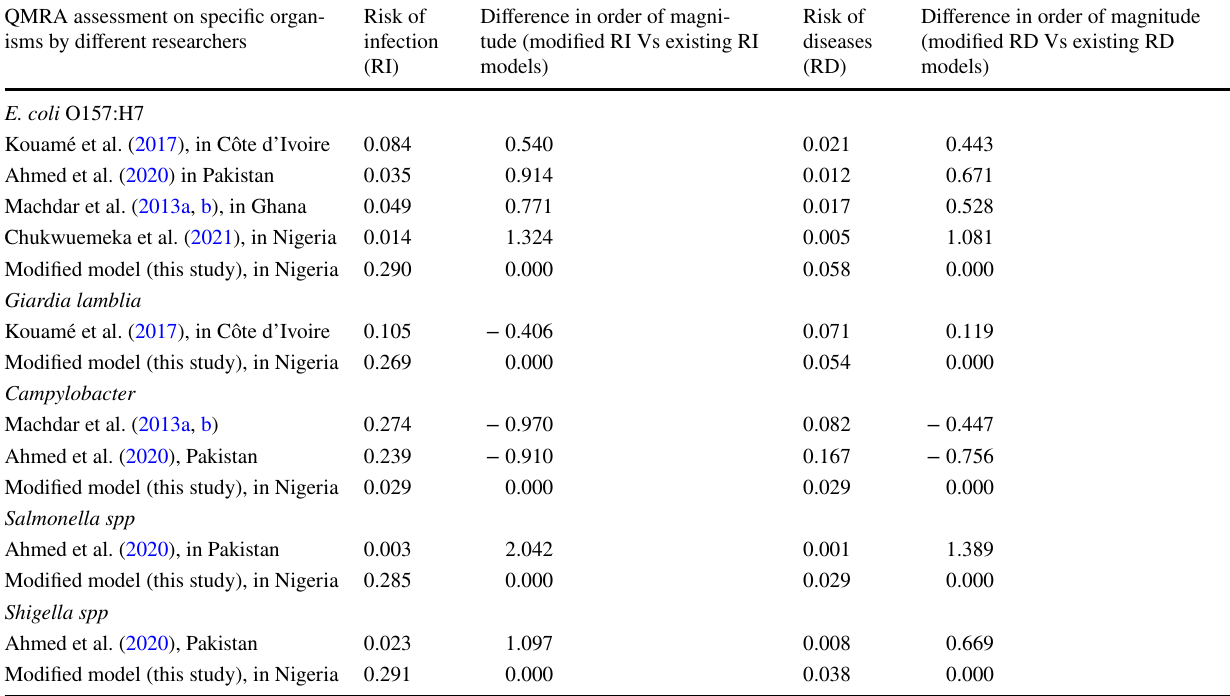
Table 13 Comparison of the results obtained using the modified QMRA model with some recent works QMRA assessment on specific organ- isms by different researchers